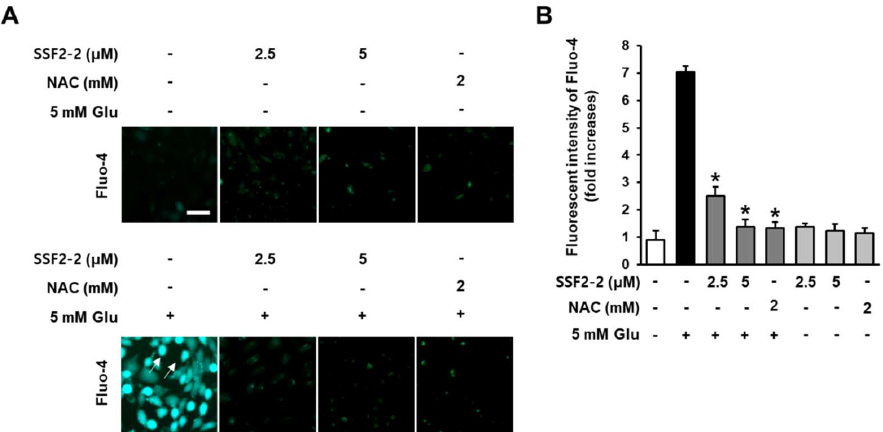
Figure 5. E ff ects of SSF2-2 on glutamate-induced excessive levels of Ca 2 + . HT22 cells were incubated for 24 h with 5 mM glutamate (Glu) with or without compound SSF2-2 and N-acetylcysteine (NAC), and then stained with Fluo-4 AM. ( A ) Fluorescent images collected using a fluorescent microscope. ( B ) Fold increases in fluorescent intensity of Fluo-4 AM. White scale bar, 40 µ m. Data represent the mean ± S.E.M., n = 3, * p < 0.05 compared with the glutamate-treated